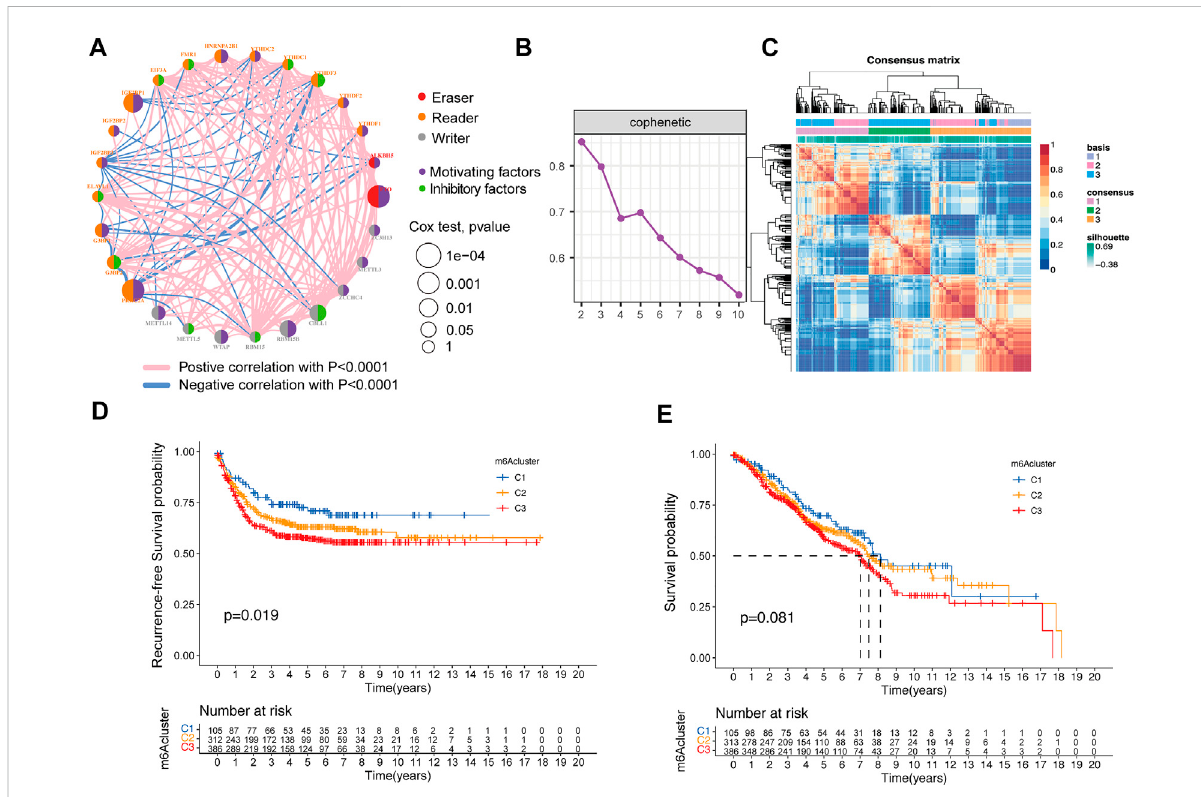
FIGURE 2 Relationship between the m 6 A methylation modi fi cation pattern and prognostic characteristics. (A) Interaction of expression on 27 m 6 A regulators in colorectal cancer. The m 6 A regulators in three RNA modi fi cation clusters were depicted by circles in different colors. Readers, orange; writers, gray;erasers,red.The lines connecting m 6 A regulatorsrepresented their interaction with eachother.The size of eachcircle represented the recurrence effect of each regulator and was scaled by the p -value. Inhibitory factors for patients ’ recurrence were indicated by a green right semicircle and motivating factors indicated by a purple right semicircle. (B) NMF rank survey result. (C) NMF analysis identi fi cation of the three m 6 A modi fi cationclusters. (D,E) Kaplan – Meiercurvesofrecurrence-freesurvival (D) andoverallsurvival (E) for804CRCpatientsinthemeta-GEOcohort with different m 6 A cluster patterns. The numbers of patients in m 6 A-cluster 1, m 6 A-cluster 2, and m 6 A-cluster 3 three phenotypes are 105, 313, and 386,